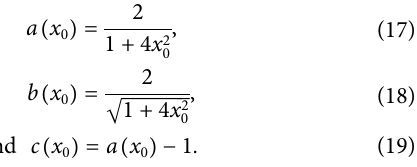
panels, respectively. For the former, different curves correspond to